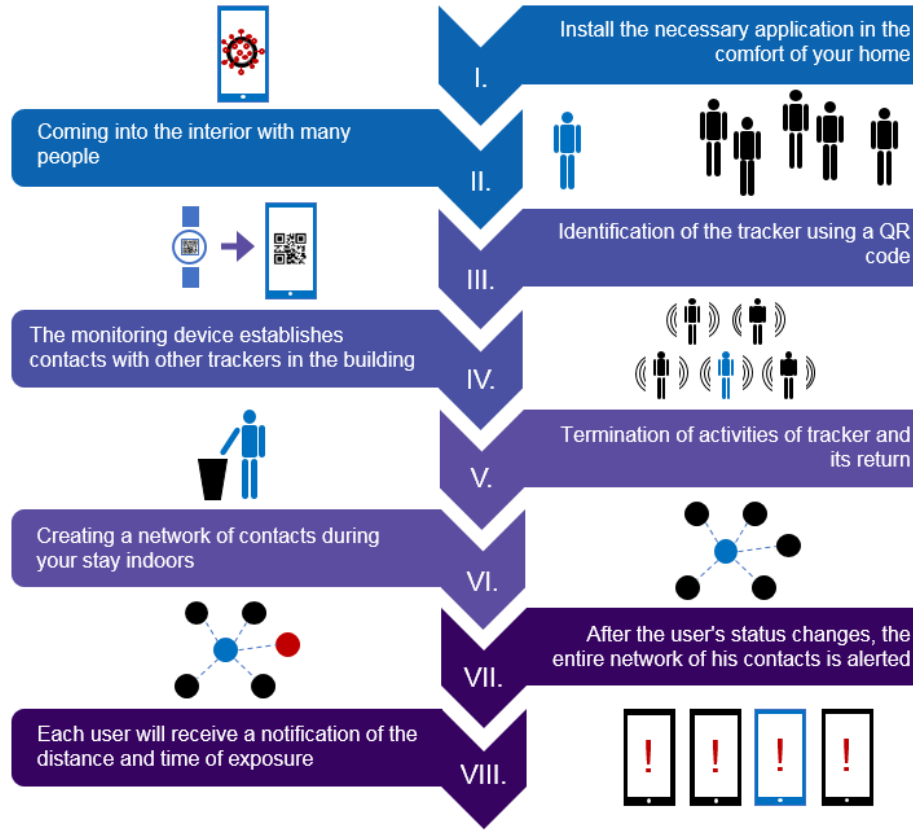
Figure 3. User interaction: linking a mobile phone to a tracking device. Graphical interpretation of